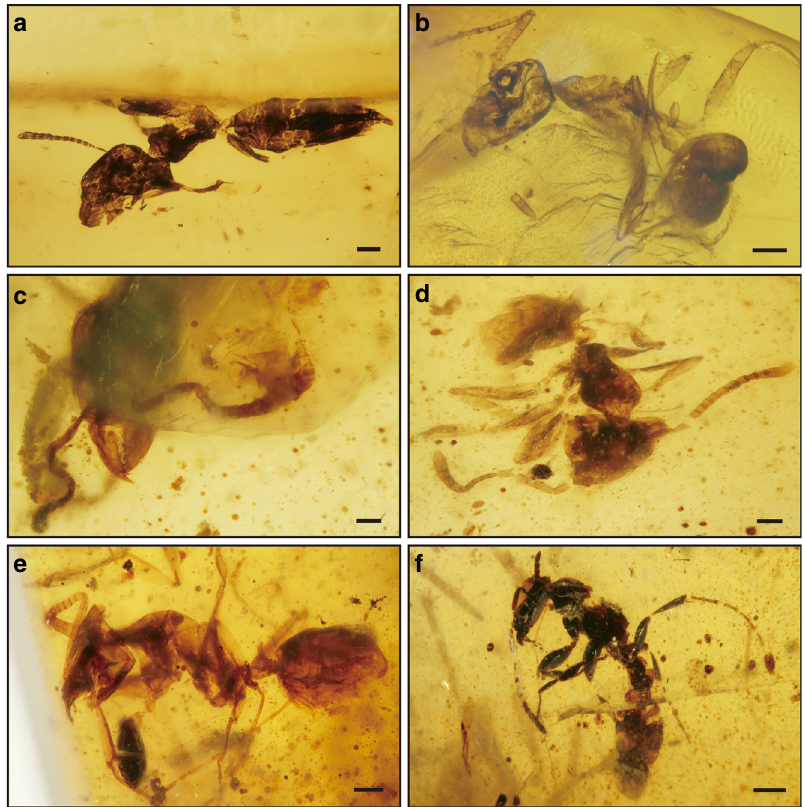
Fig. 3 Photographs of Formicidae in Tilin amber. a Dolichoderinae, genus A, NIGP168510. b Dolichoderinae, genus B, NIGP168511. c Dolichoderinae, genus C, NIGP168512. d , e Dolichoderinae, genus B?, NIGP168513. f , Ponerinae?, female specimen, NIGP168514. Scale bars, 0.2 mm ( a , b , d , e ), 0.1 mm ( c ), and 0.4 mm ( f